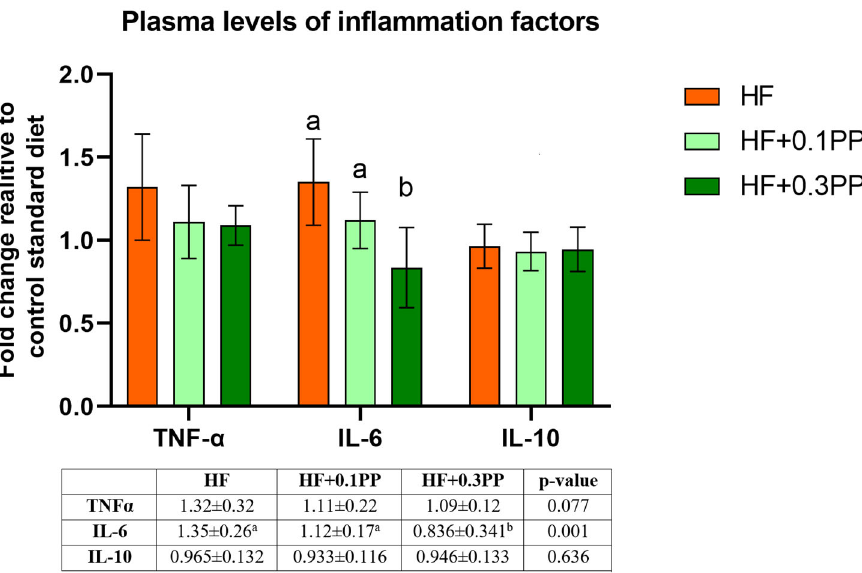
Figure 1. The levels of TNF α , IL-6, and IL-10 in the plasma of rats fed experimental diets (expressed as fold change relative to the control). The values are the means ± SEMs. HF, group fed a high-fat diet; HF + 0.1PP, group fed a high-fat diet supplemented with 0.1% raspberry polyphenolic extract; HF + 0.3PP, group fed a high-fat diet supplemented with 0.3% raspberry polyphenolic extract. Mean values with different superscript letters (a or b) are different at p < 0.05 (post hoc test). TNF α , tumor necrosis factor α ; IL ‐ 6, interleukin 6; IL ‐ 10, interleukin 10.